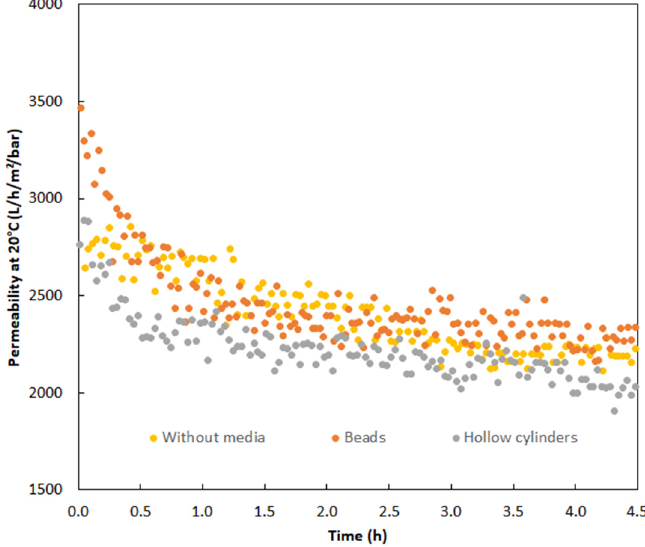
Figure 11. Evolution of the permeability of the membrane for water at 20 °C, with and without solid media.